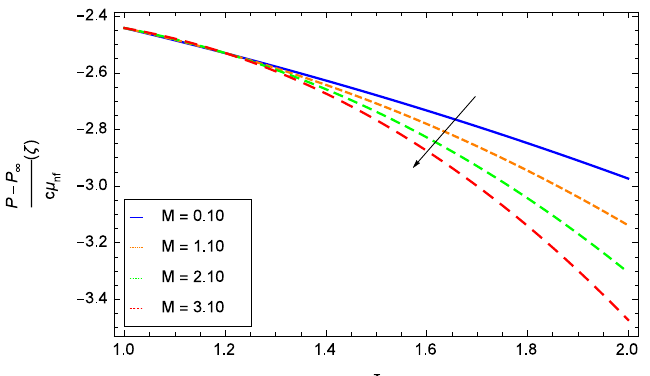
Figure 16. Non-dimensional Pressure P − P ∞ ( ζ ) sketch for h = − 0.10, β 1 = 1.70, M = 0.10, Re = 0.70, c µ nf φ = 0.04, Pr = 6.80 and greater quantities of M (CuO-H 2 O).